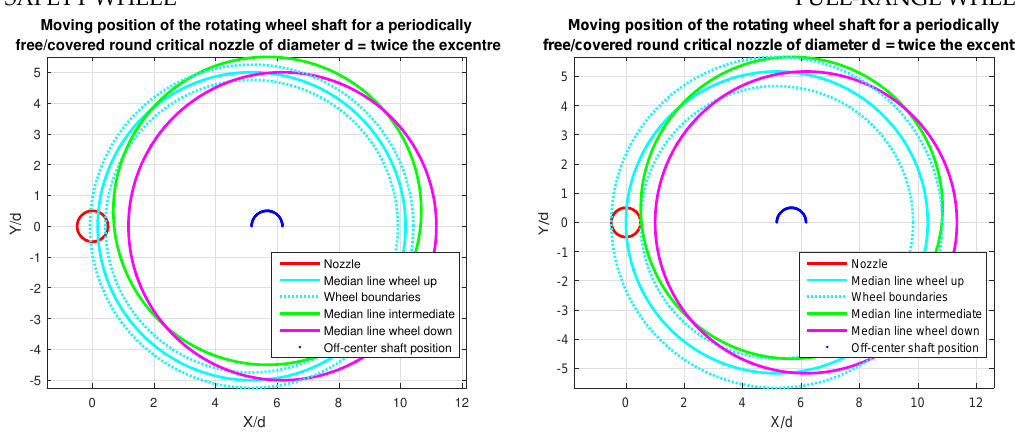
Figure 9. Relative position of the cogged wheel (mobile) versus the nozzle surface (fixed), for the safety and full-range versions.